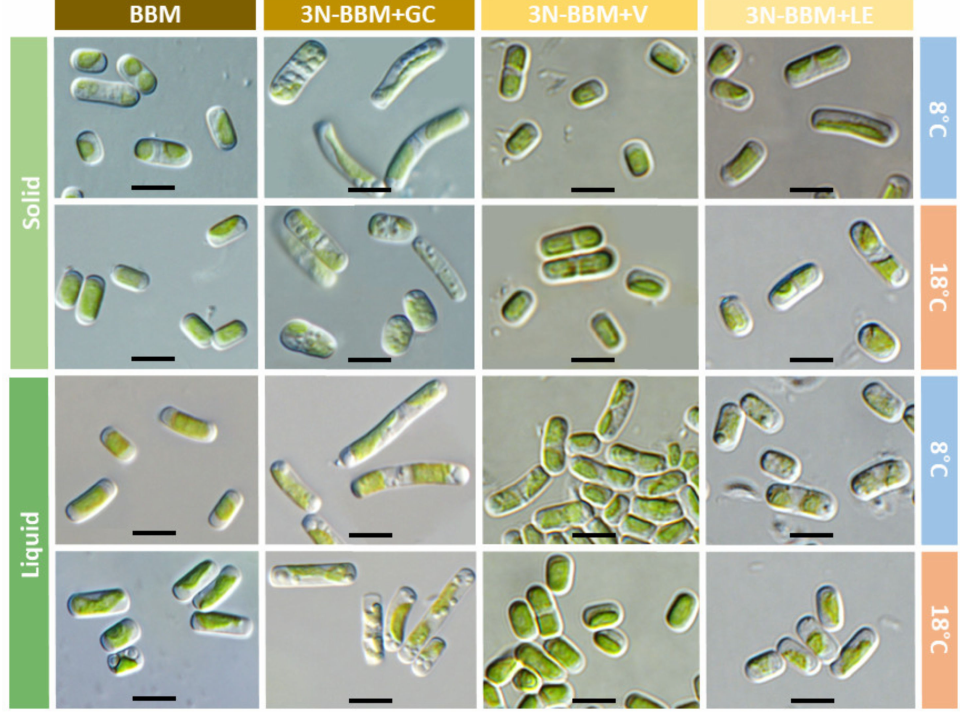
Figure 5. Morphology and phenotypic plasticity of Diplosphaera elongata sp. nov. after 21 days of growth under different conditions. Scalebars: 5 µ